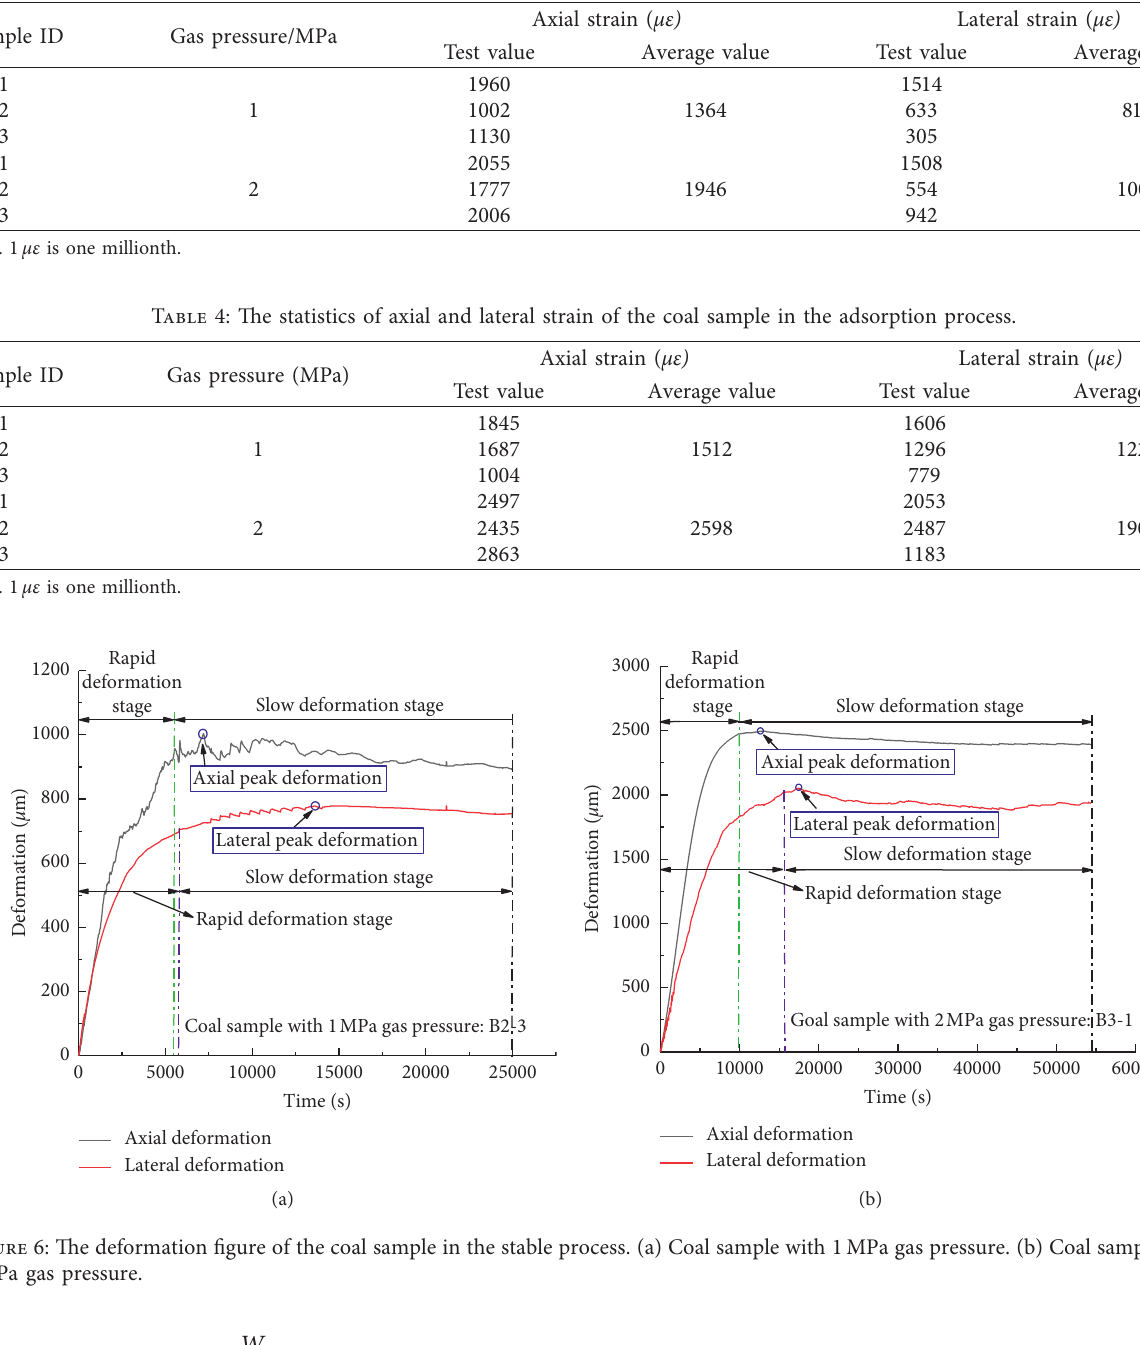
Table 3: Statistics of axial and lateral strain of the coal sample in the aeration process.